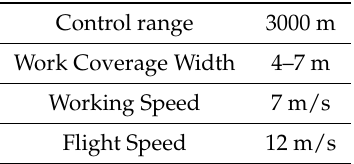
Table 8. Operating